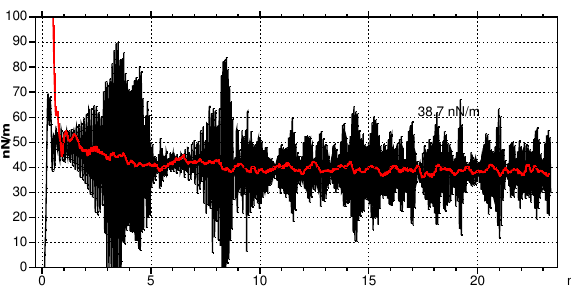
Figure 14. Run BzLong: B z = 30 000nT and 23.4ms